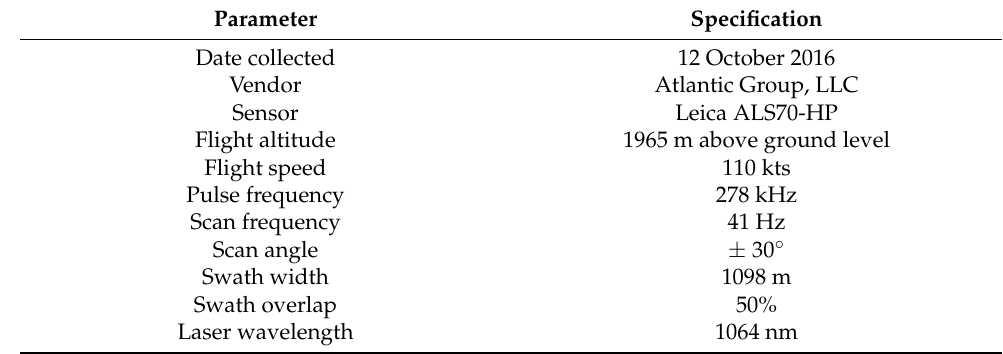
Table 1. Lidar acquisition parameters. The discrete-return airborne lidar (also airborne laser scanning, ALS) data from the two study sites (based on IPNF Ranger Districts: Coeur d’Alene River, CdA; Saint Joe, StJ) were part of a larger acquisition carried out by USFS RMRS in 2016 (see [36] for more